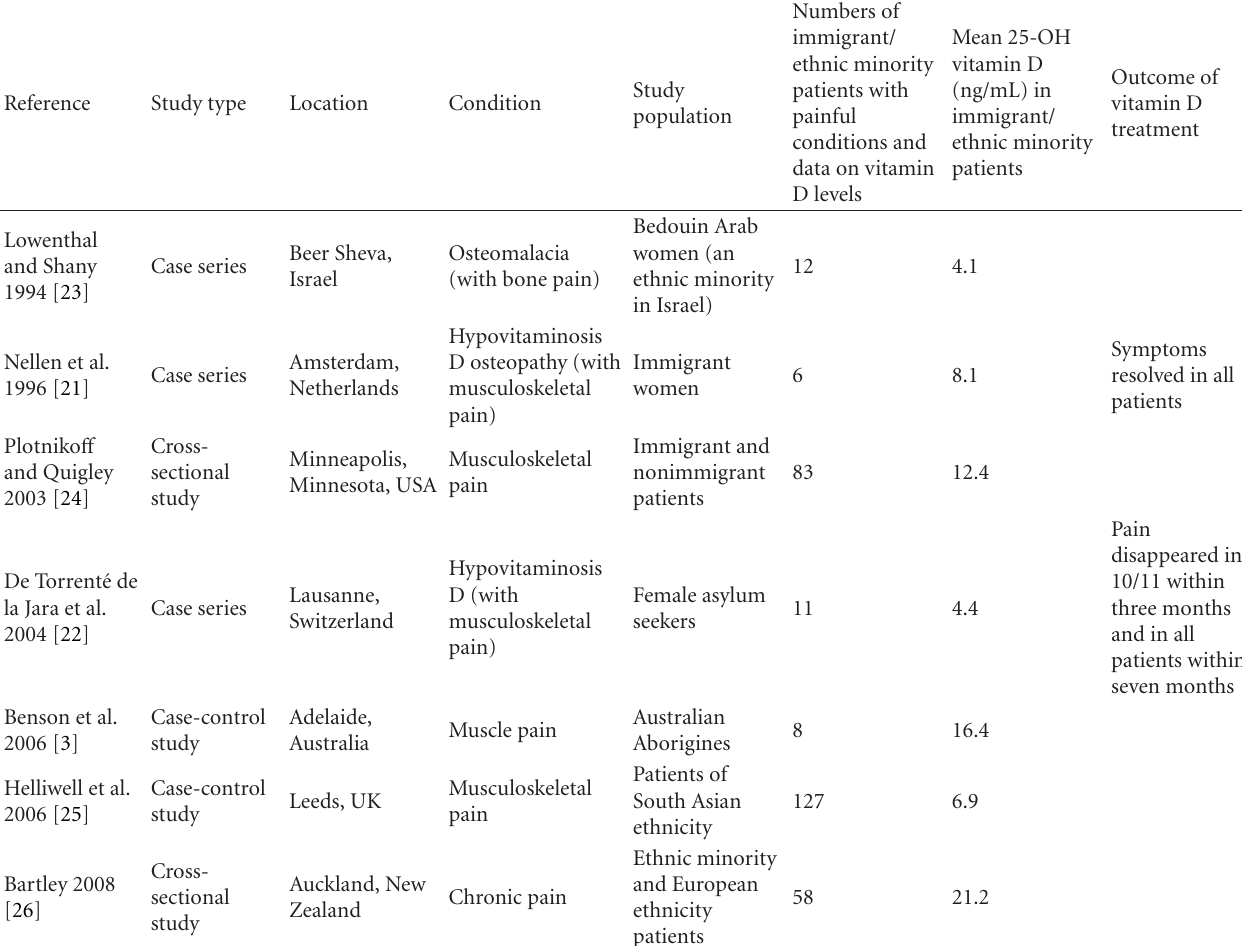
Table 1: Characteristics of included